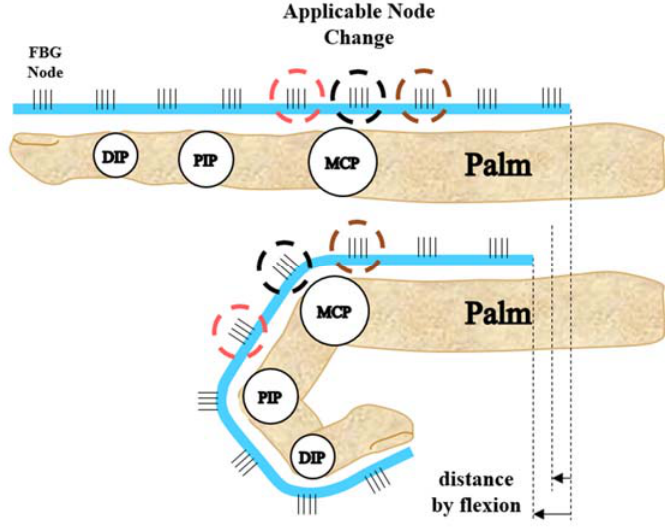
Figure 5. Positional changes of FBG nodes in the FBG strain sensor measuring the metacarpophalangeal (MCP) joint angle.